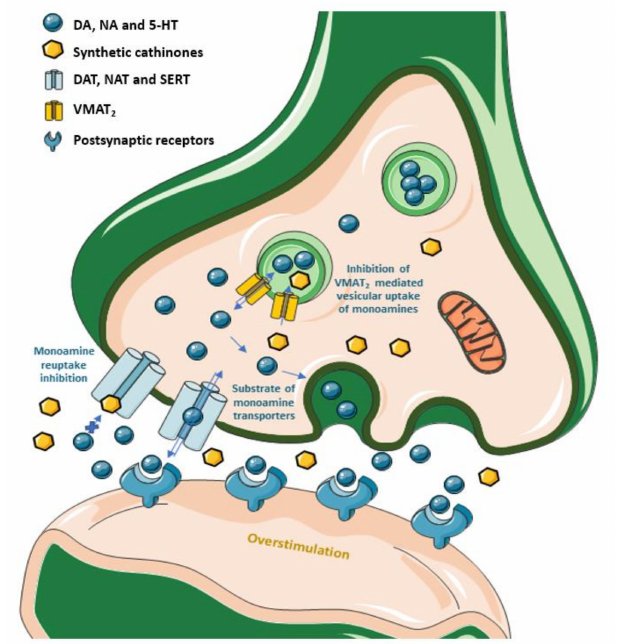
Figure 11. Modes of action of synthetic cathinones in the central nervous system. (DA: dopamine; NA: noradrenaline; 5-HT: 5-hydroxytryptamine (serotonin); DAT: dopamine transporters; NAT: nora- drenaline transporters; SERT: serotonin transporters; VMAT 2 : vesicular monoamine